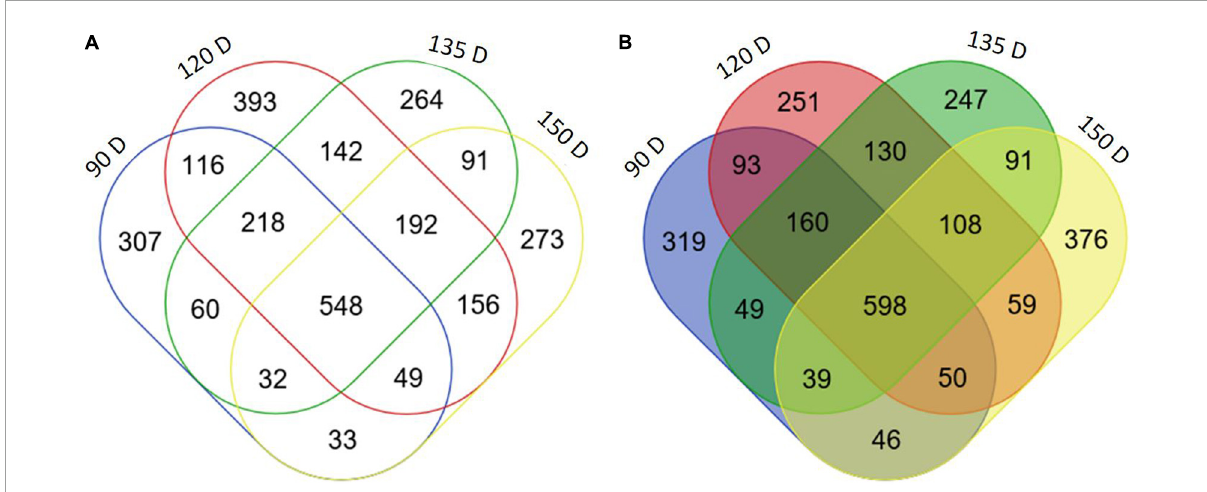
FIGURE4 Differentially expressed genes in PSY transgenic apple fruit. Venn diagram of number of differentially expressed genes (log 2 fold change ≥ 2, P < 0.05) between WT and OE-7 fruit at four developmental stages (90, 120, 135, 150 D). Upregulated (A) , downregulated (B) in PSY fruit flesh.